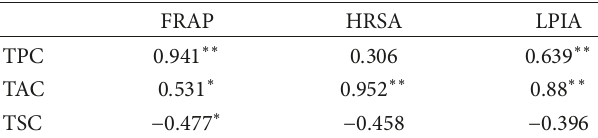
Table 1: Pearson’s correlation coefficients of FRAP, HRSA, and LPIA versus TPC, TAC, and